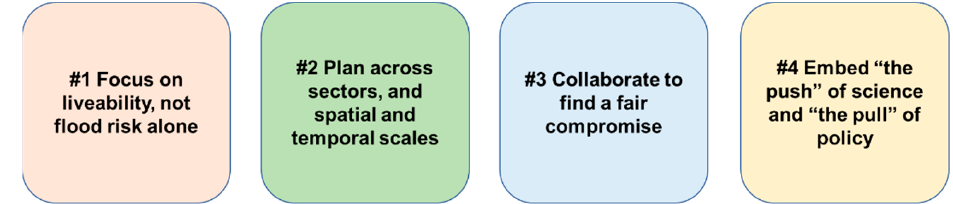
Figure 7. The four policy directions to support the adoption of a Cloud to Coast